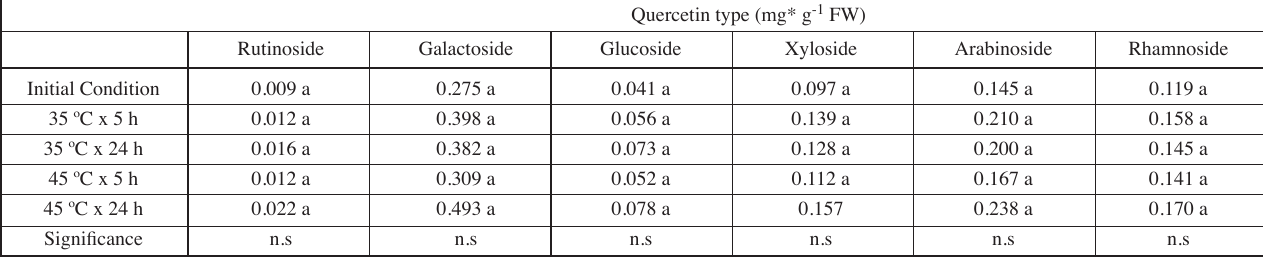
Tab. 2: Concentration of quercetin glycosides in peel cv. Fuji exposed to 35 °C and 45 °C (150